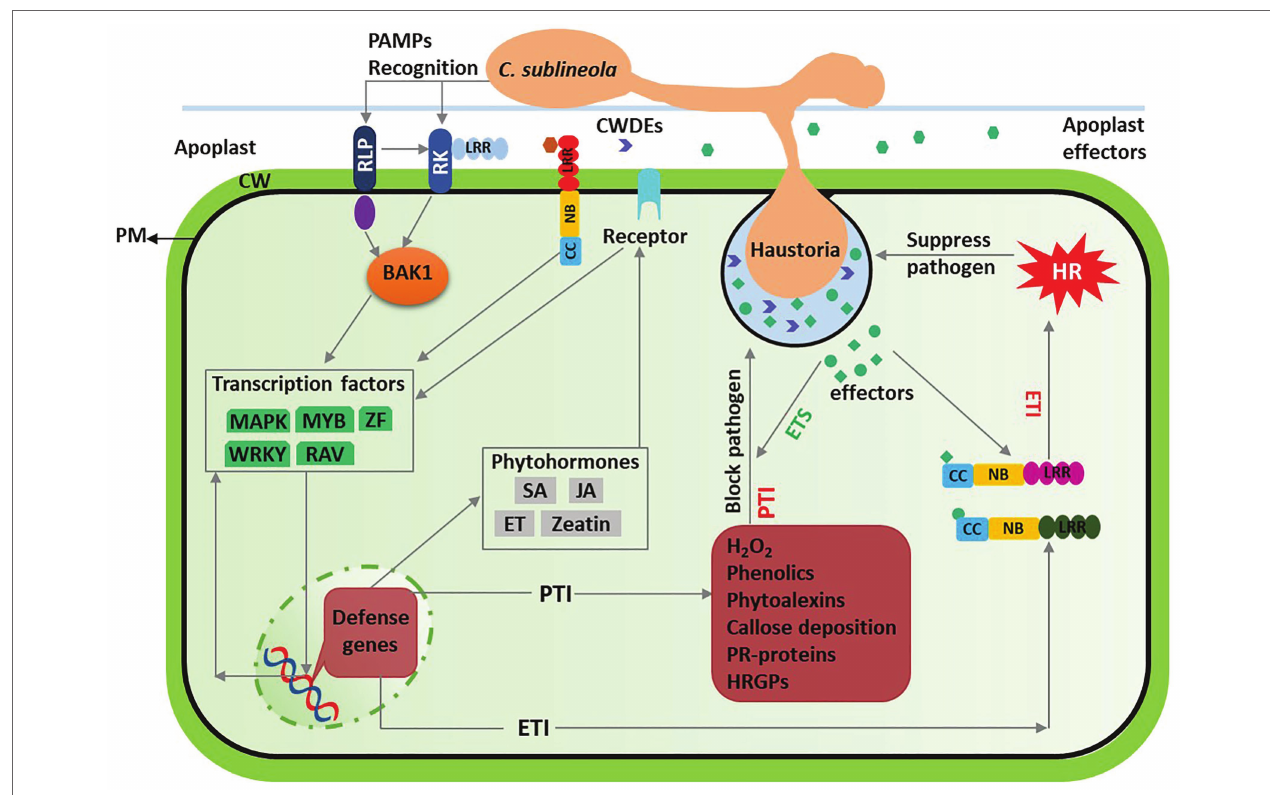
FIGURE 2 | Overview of sorghum- Colletotrichum sublineola interactions. Spores of C. sublineola land on sorghum tissue, propagate into germ tubes, and form appressoria, which are specialized infection structures. The infection penetrates the host cell wall (CW) and forms feeding structures called haustoria. During the course of infection, pathogenicity molecules, such as cell wall degrading enzymes (CWDEs) and effectors are secreted into the extracellular space. The CWDEs and ubiquitous structural molecules such as chitin are recognized as Pathogen associated molecular patterns (PAMPs) by the host cell receptors, receptor kinases (RK), and receptor like proteins (RLP). These receptors interacts with extracellular leucine rich repeat (LRR) and intracellular BRASSINOSTEROID INSENSITIVE 1-ASSOCIATED KINASE 1 (BAK1) activating the PAMP-triggered immunity (PTI). Host PTI response is characterized by increased accumulation of hydrogen peroxide (H 2 O 2 ), phenolics, phytoalexins, hydroxyprolinerich glycoproteins (HRGPs), pathogenesis- related (PR-) proteins, and callose deposition around the point of infection and suppress pathogen growth. In susceptible genotypes, the pathogen secrets effectors that suppress the PTI whereas in resistant genotypes these extracellular and intracellular effectors are recognized by the host nucleotide-binding (NB) LRR (NB-LRR) receptors. This recognition induces the effector-triggered immunity (ETI) primarily recognized by accumulation of H 2 O 2 resulting in hypersensitive response (HR), which is a form of programmed cell death. The ETI response blocks C. sublineola transition to necrotrophic phase and arrests the pathogen growth. Both PTI and ETI responses involve transcriptional factors (green) and phytohormones (gray), involved in signaling transduction, regulation of defense-related genes, and host